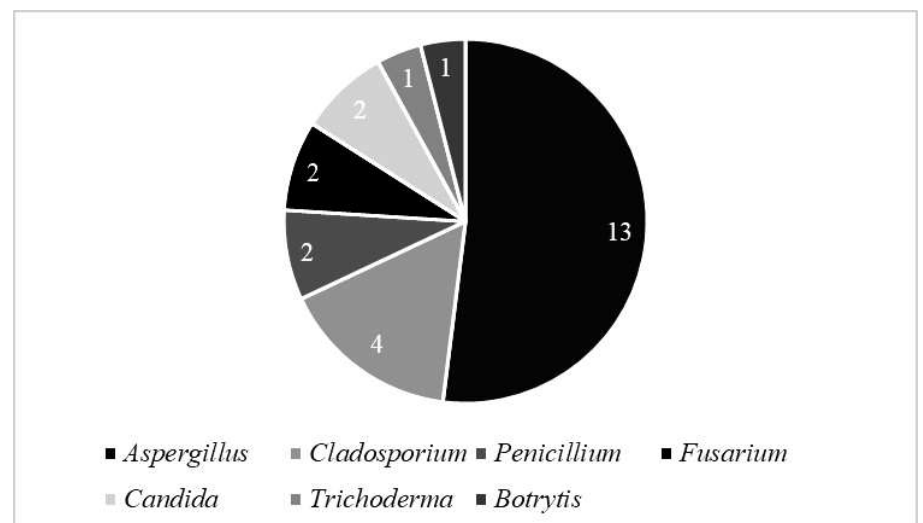
Figure 2. The isolated genera of fungi and the number of